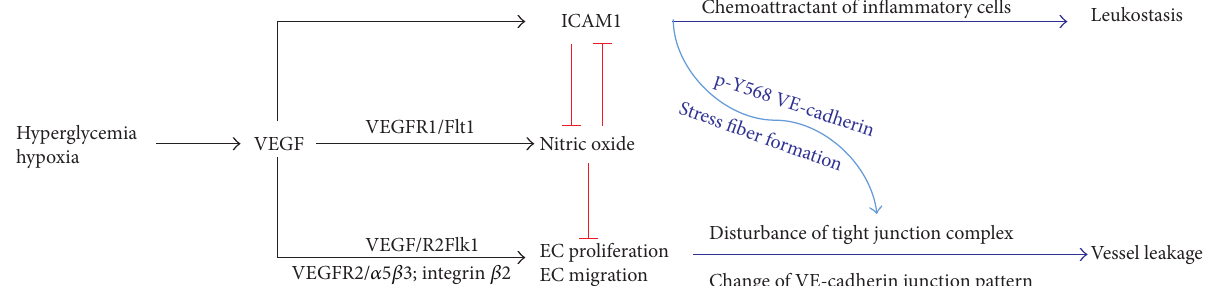
Figure 1: Uncoupling VEGF with nitric oxide in microvascular endothelial cells. Hyperglycemia promoted local VEGF production. VEGF stimulated endothelial cell proliferation via binding to VEGFR2. It induced endothelial cell migration and altered junction complex, in particular, VE-cadherin on the membrane. In parallel, VEGF promoted ICAM1 expression in endothelial cells which triggered inflammatory response to attack endothelium and made VE-cadherin dissemble. ICAM1 could also enhance ROS production that has negative impact on nitric oxide level and bioavailability. Although VEGF promoted nitric oxide production in endothelial cells via its receptor Flt1, nitric oxide is significantly reduced by ROS and oxidative stress, losing its inhibitory effect on VEGF-induced endothelial cell proliferation, migration, and